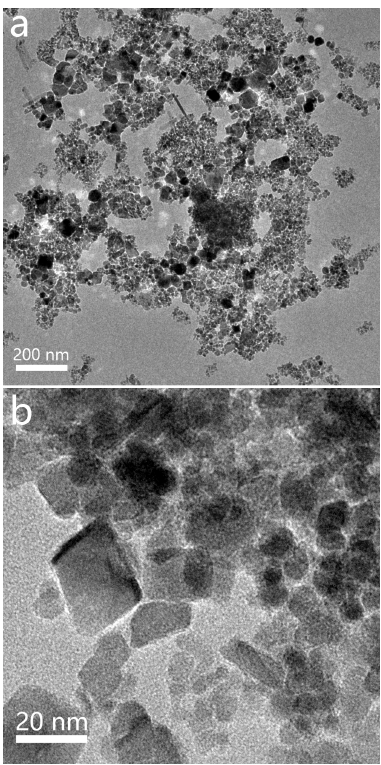
Figure 1. TEM images of Fe 3 O 4 /TiO 2 /C nanocomposites (FTCNCs). ( a ) Low magnification; ( b ) higher magnification.